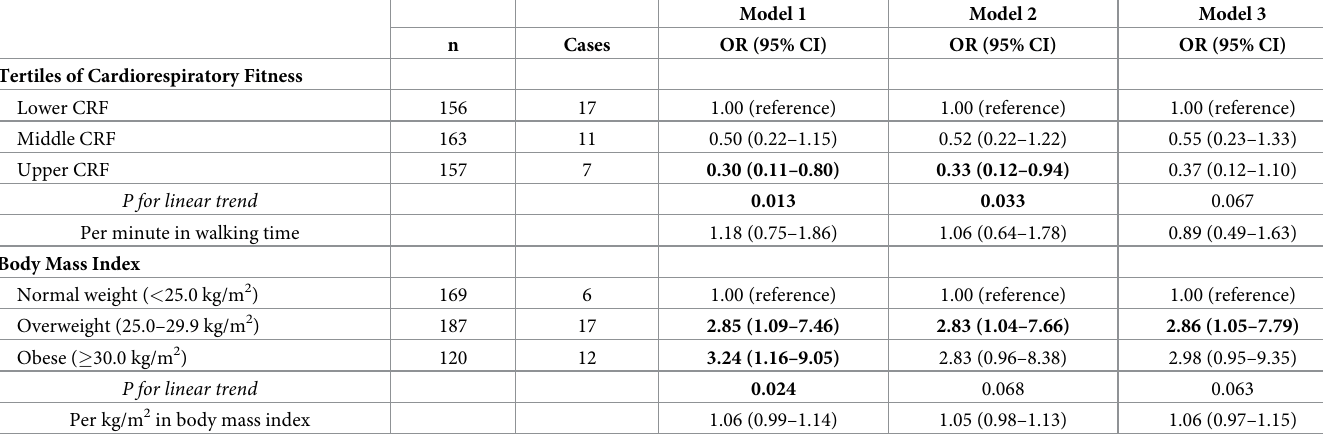
Table 2. Odds ratios (ORs) and 95% confidence intervals (95% CIs) for diverticulitis according to cardiorespiratory fitness and body mass index.